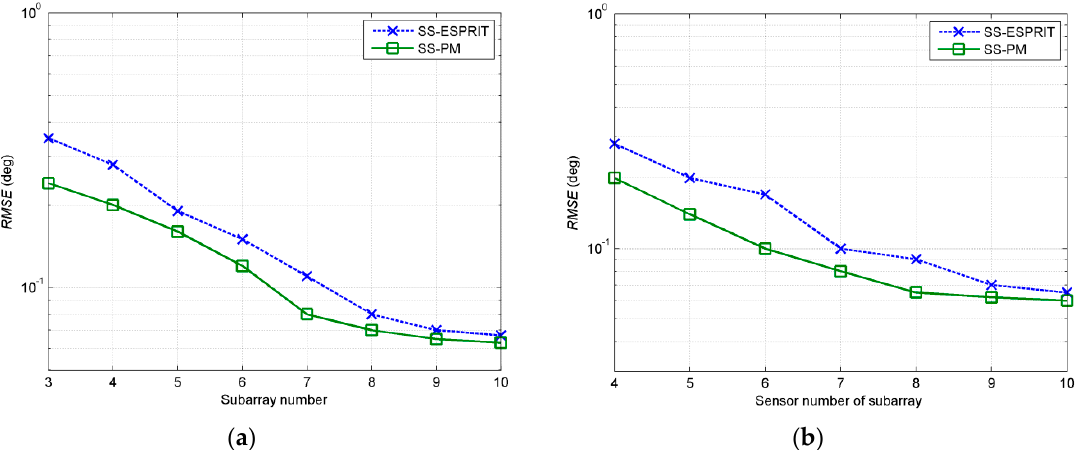
Figure 5. ( a ) RMSE estimated by the proposed methods versus subarray number P with D = 4; ( b ) RMSE estimated by the proposed versus sensor number parameter D with P = 4.